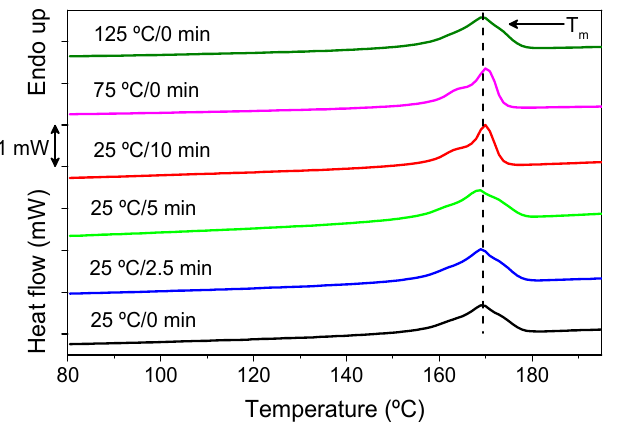
Figure 3. Differential scanning calorimetry (DSC) thermograms of representative PVDF membranes.